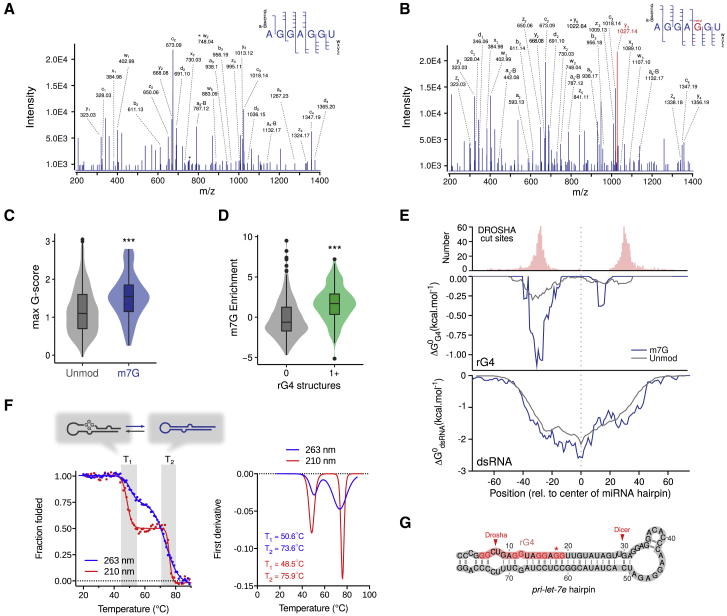
G-Quadruplexes Mark m7G-Containing miRNAs(A and B) Spectral sequencing of in vivo let-7e-5p showing unmodified (A) and methylated 5′-AGGAGGU-3′ (B) fragments, obtained following RNase A digestion of a miRNA fraction isolated from A549 cells (see also Figure S5).(C) Boxplot showing the maximum G-score, a quantitative estimation of G-richness and G-skewness (see Method Details for definition), in primary hairpins of either unmodified or m7G containing miRNAs (∗∗∗p < 0.001, Wilcoxon test).(D) Boxplot showing the enrichment of miRNAs, grouped according to the propensity of their primary hairpins to form G-quadruplexes (∗∗∗p < 0.001, Wilcoxon test).(E) Metagene plot showing pri-miRNA cleavage site distribution (top) and the predicted stability of G-quadruplexes (center), and double strand (bottom) across primary hairpins of unmodified (gray) or m7G-modified miRNAs (blue).(F) Denaturation experiments of let-7e primary hairpin in the presence of 100 mM KCl followed by circular dichroism at 263 or 210 nm show two transitions demonstrating that let-7e exists as a mixture of two distinct structures in equilibrium in solution (top). The first structure melts at 48.5°C–50.6°C, while the second one is more stable (75.9°C–73.6°C).(G) Scheme showing the predicted G-quadruplex (rG4, pink) within the pri-let-7e hairpin. In red are shown the guanosines predicted to be involved in the formation of the quadruplex motif. Arrows mark the cleavage sites of let-7e-5p processing. The asterisk indicates the position of m7G.See also Figure S6.